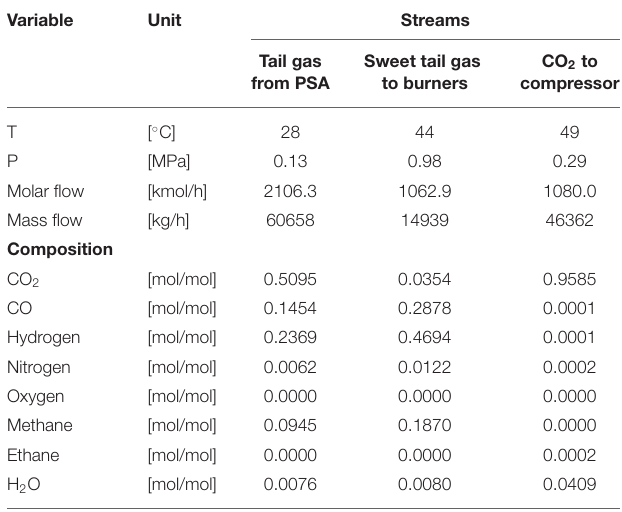
TABLE 1 | Data on the main streams involved in the CO 2 capture section studied in this work (IEAGHG, 2017).